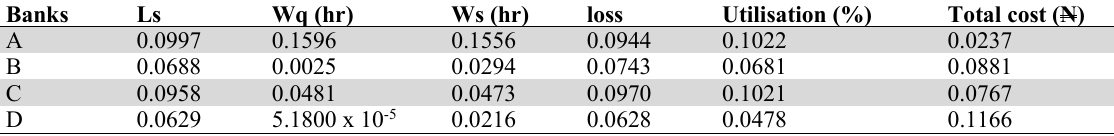
Normalised weighted decision matrix of the study Banks